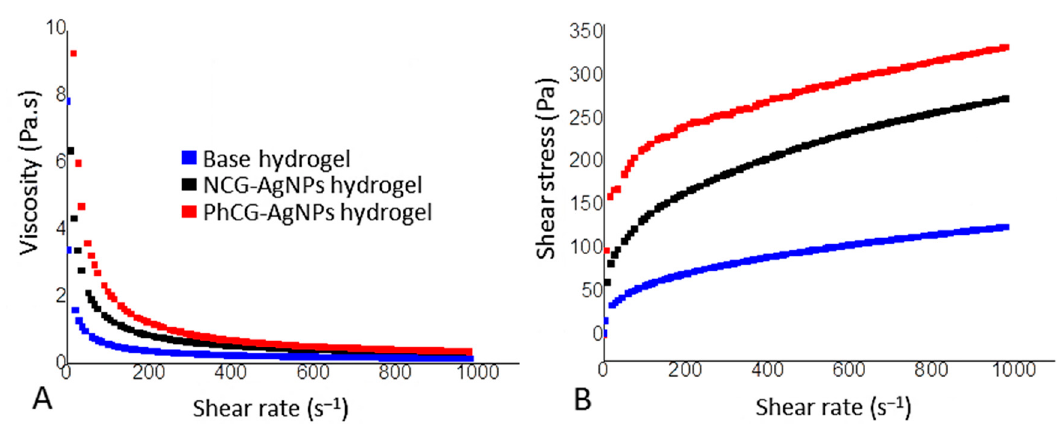
Figure 6. Rheological analysis of hydrogels formulated with AgNPs: Viscosity ( A ) and Shear stress ( B ).